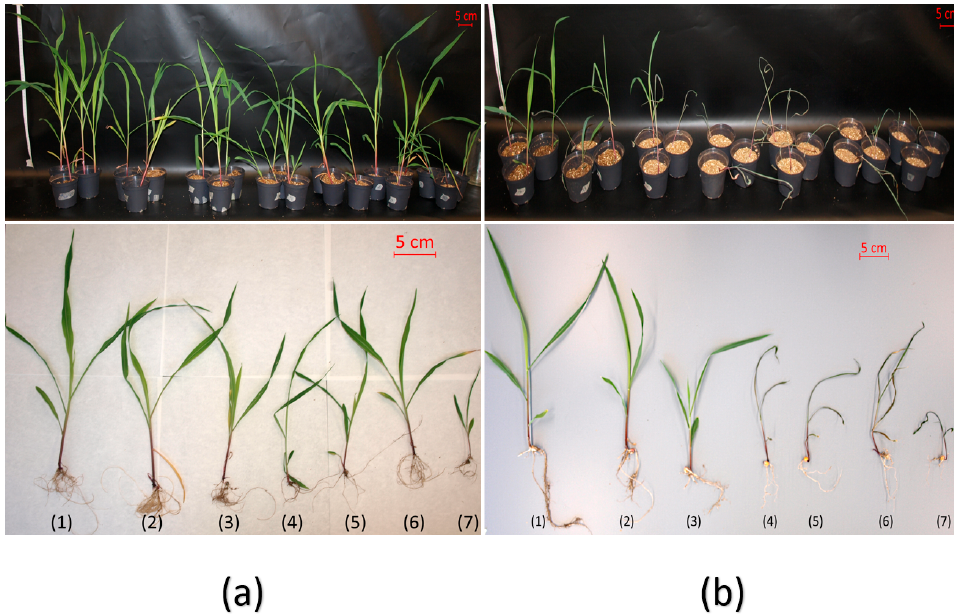
Figure 2. Phenotype registered in maize plants under capsuled-seed treatment in lab tests. ( a , b ) These pictures show the 14 DAT phenotype of seedlings treated with capsuled xerotolerant strains under regular irrigation ( a ) and drought ( b ) conditions, both in pots and in full-plant view. Applied treatments were: (1) Microbacterium sp. 31J, (2) Arthrobacter koreensis 5J12A, (3) Rhodococcus globerulus 4J2A2, (4) Leucobacter sp. 4J7B1, (5) Pseudarthrobacter siccitolerans 4J27, (6) Pseudomonas putida KT2440 and (7) mock. Three repetitions of three replica ( n = 9) were prepared for this test. Red bar indicates a 5-cm reference in the picture.